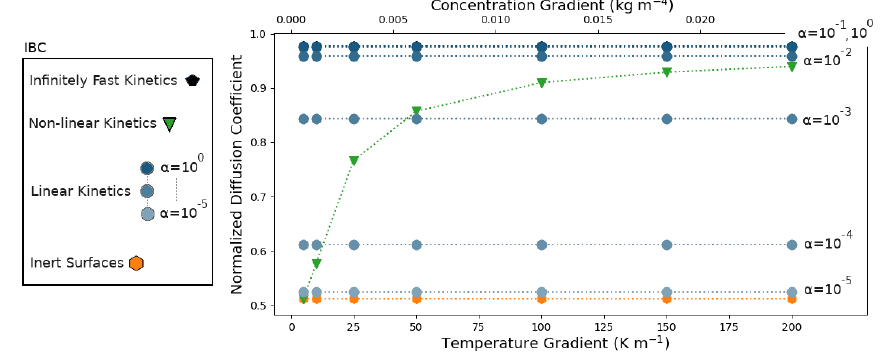
Figure 4. Normalized diffusion coefficients D norm in the idealized sphere microstructure for different temperature and vapor gradients, eff different IBCs, and a mean temperature of 258K. Note that the α = 0 . 1, α = 1, and infinitely fast kinetics cases are indistinguishable at the top of the graph.